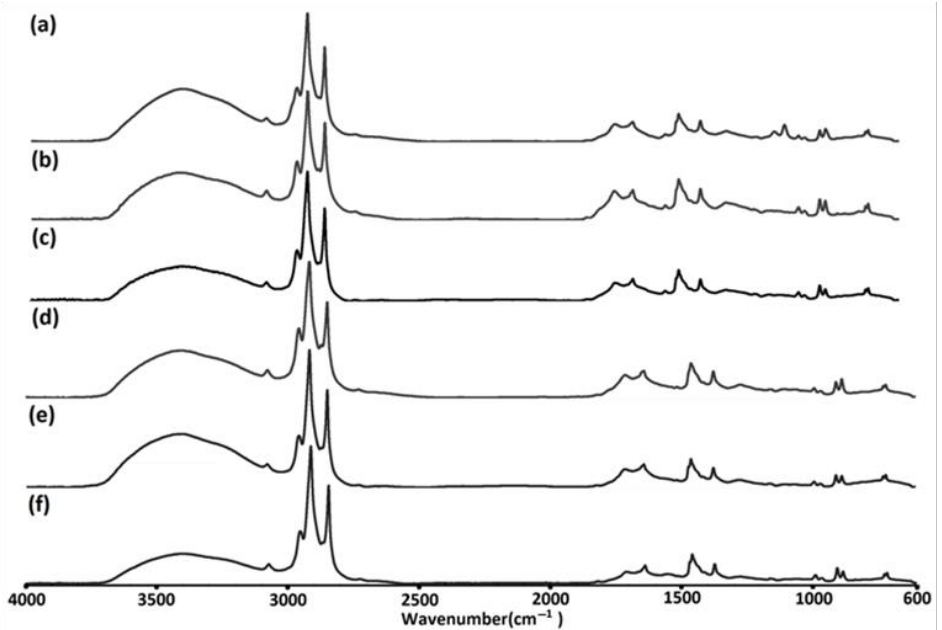
Figure 8. FTIR spectra of wax products of thermal pyrolysis of BMP at ( a ) 500 °C, ( b ) 550 °C, ( c ) 600 °C and CMP at ( d ) 500 °C, ( e ) 550 °C, and ( f ) 600 °C .